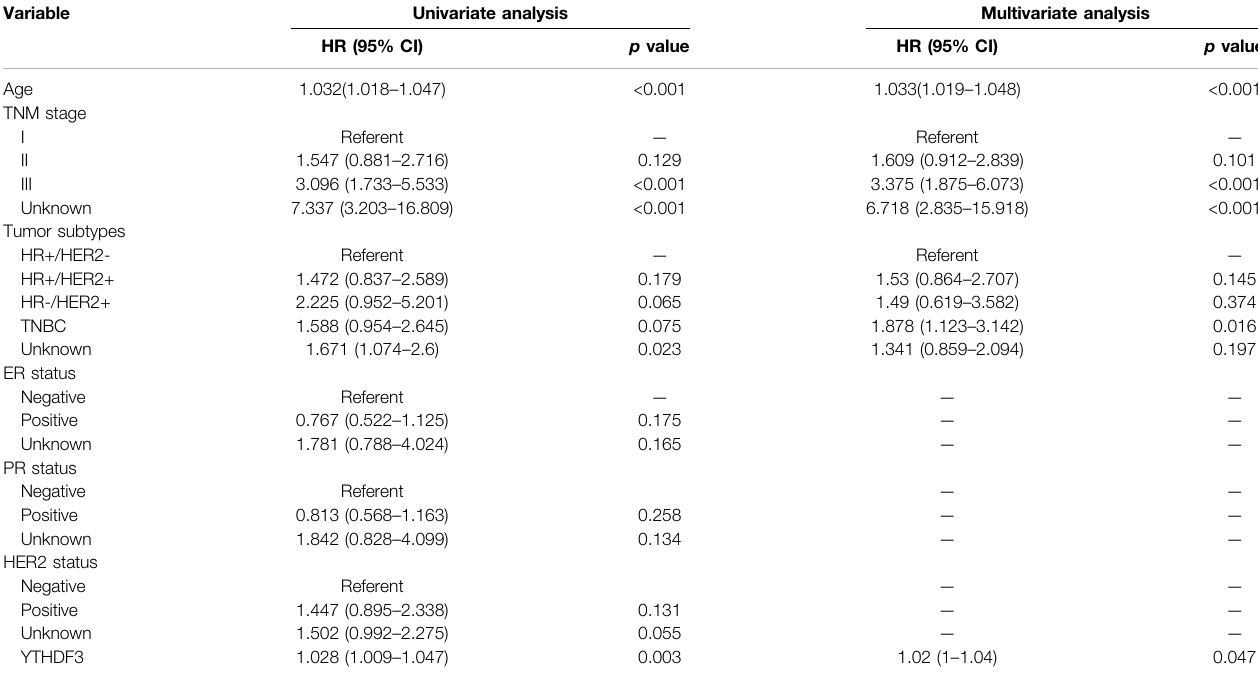
TABLE 2 | Univariate and multivariate Cox proportional hazards regression analyses in BC